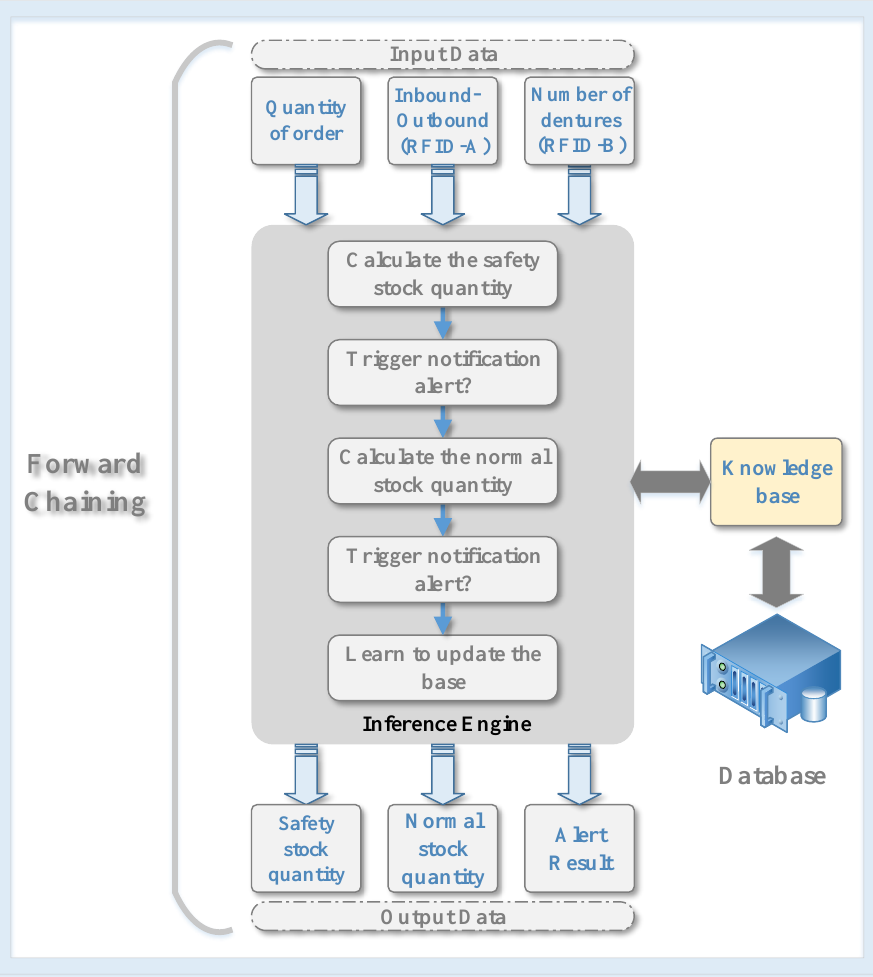
Figure 4. The architecture of the expert system.